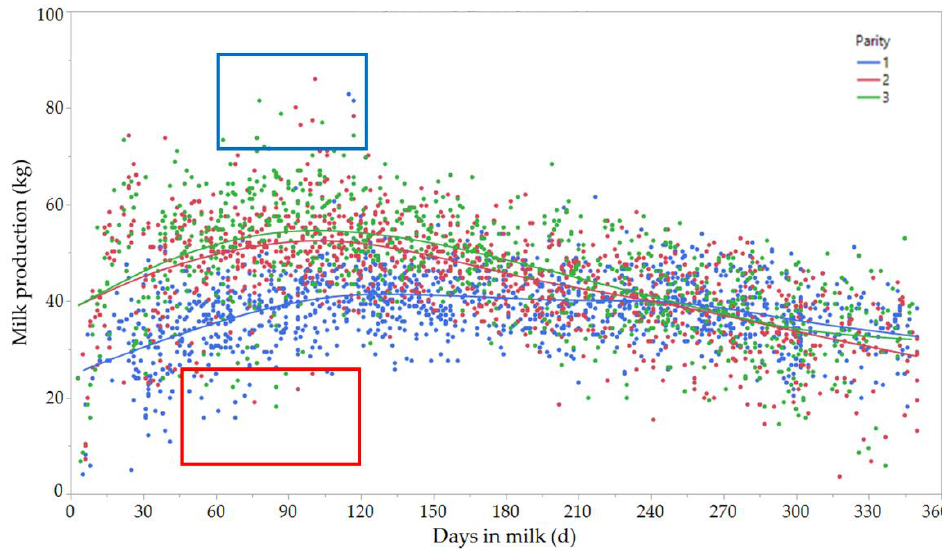
Figure 1. Milk production (kg; vertical axis) by days in milk (DIM; horizontal axis) for different parity groups. The upper blue square highlights peak milk production between 60 and 120 DIM. The lower red rectangle highlights problem cows (outliers characterized by low milk production, compared with the rest of the herd between 50 and 120 DIM). Parity 1 (lactation = 1; blue dots), Parity 2 (lactation = 2; red dots), Parity 3 (lactation > 3; green dots). Continuous lines represent the average milk production for each parity group by days in milk.